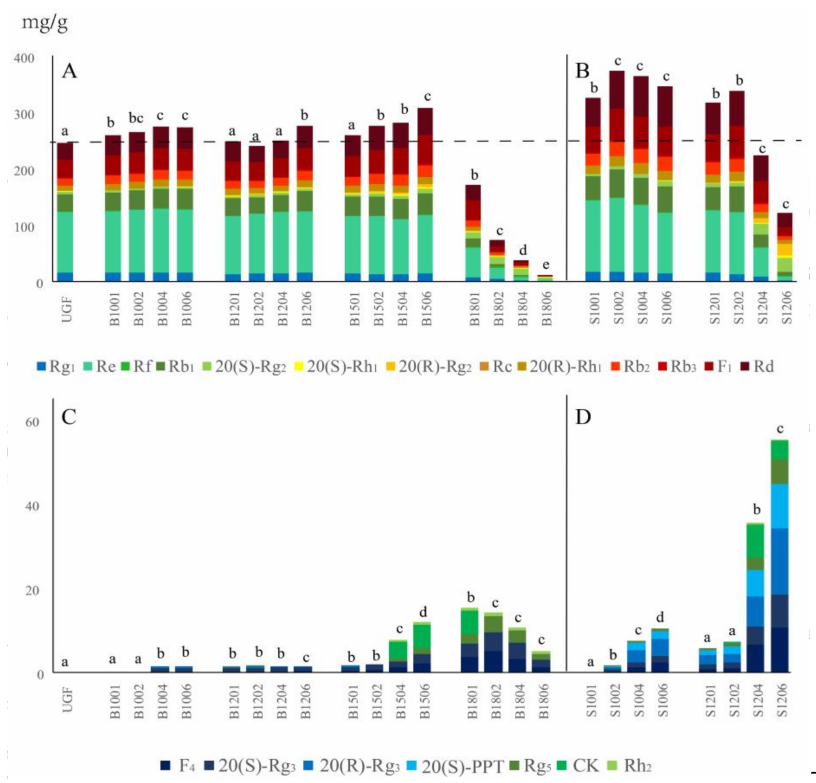
Figure 3. Changes in contents of polar and less-polar ginsenosides in heated ginseng flowers. Shown are contents of polar ( A , B ) or less-polar ( C , D ) ginsenosides, as indicated by differently-colored columns, in ginseng flowers with various regimes of baking (( A ) or ( C )) and steaming (( B ) or ( D )). Values marked by the same letter are not significantly different ( p > 0.05), and those marked by different letters at same temperatures are significantly different ( p < 0.05) to those of unheated ginseng flowers